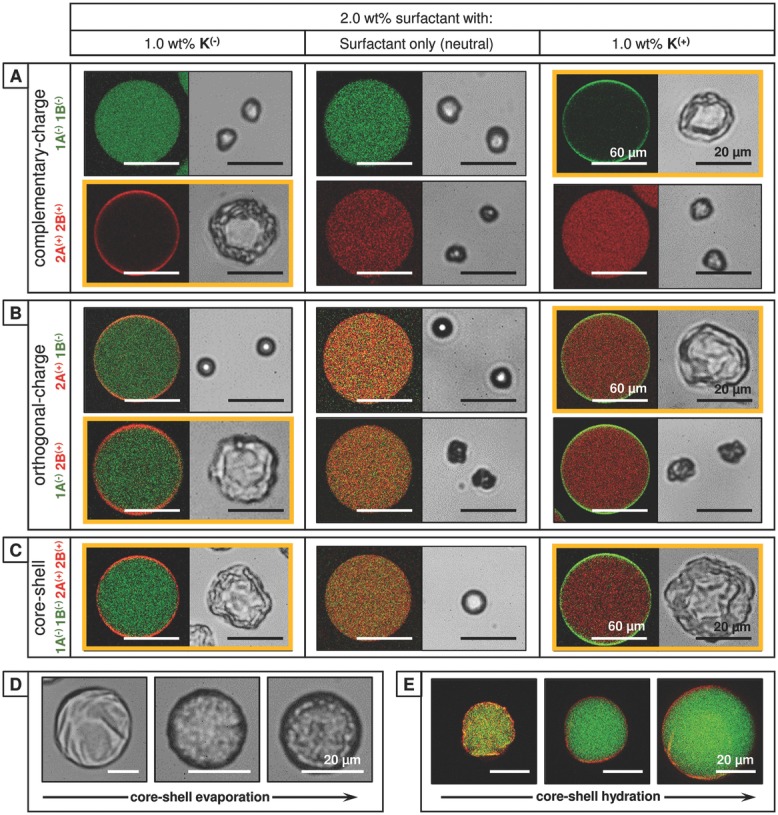
Table correlating the distribution of fluorescent copolymer in the microdroplet (left) with the resultant microstructure formed upon evaporation (right), as a function of the charge at the droplet interface. A) Complementary: Negative copolymers 1A(−) and 1B(−) (fluorescein-labeled, green) were found to exclusively form a hollow microcapsule in the presence of K(+) [azo:MV:CB[8] = 60:60:60 × 10−6
m]. Conversely, positive copolymers 2A(+) and 2B(+) (rhodamine-labeled, red) were found to exclusively form a microcapsule with K(−) [stil:MV:CB[8] = 60:60:60 × 10−6
m]. B) Orthogonal: A mixed solution of negative 1A(−) and positive 2B(+) was found to exclusively form a hollow microcapsule in the presence of K(−) [azo:MV:CB[8] = 60:60:60 × 10−6
m]. Conversely, a mixed solution of positive 2A(+) and negative 1B(−) exclusively formed microcapsules with K(+) [stil:MV:CB[8] = 60:60:60 × 10−6
m]. C) Core–shell: A mixed solution of 1A(−), 1B(−), 2A(+), and 2B(+) formed homogenous microparticles under neutral conditions. However, core–shell microcapsules were formed with both K(+) and K(−) dopants, with the outer shell comprising of either 1A(−) ⊂ CB[8] ⊂ 1B(−), or 2A(+) ⊂ CB[8] ⊂ 2B(+), respectively [CB[8]:guests = 120:60 × 10−6
m]. D) Transmission images of the evaporative formation of a core–shell microcapsule containing 160 × 10−6
m of dextran cargo (70 kDa) and E) laser-scanning confocal fluorescence image of this core–shell microcapsule during hydration at t = 0, 15, and 30 min, illustrating the partitioned copolymers within the cross-linked microstructure (shell: 2A(+) ⊂ CB[8] ⊂ 2B(+), core: 1A(−) ⊂ CB[8] ⊂ 1B(−)).